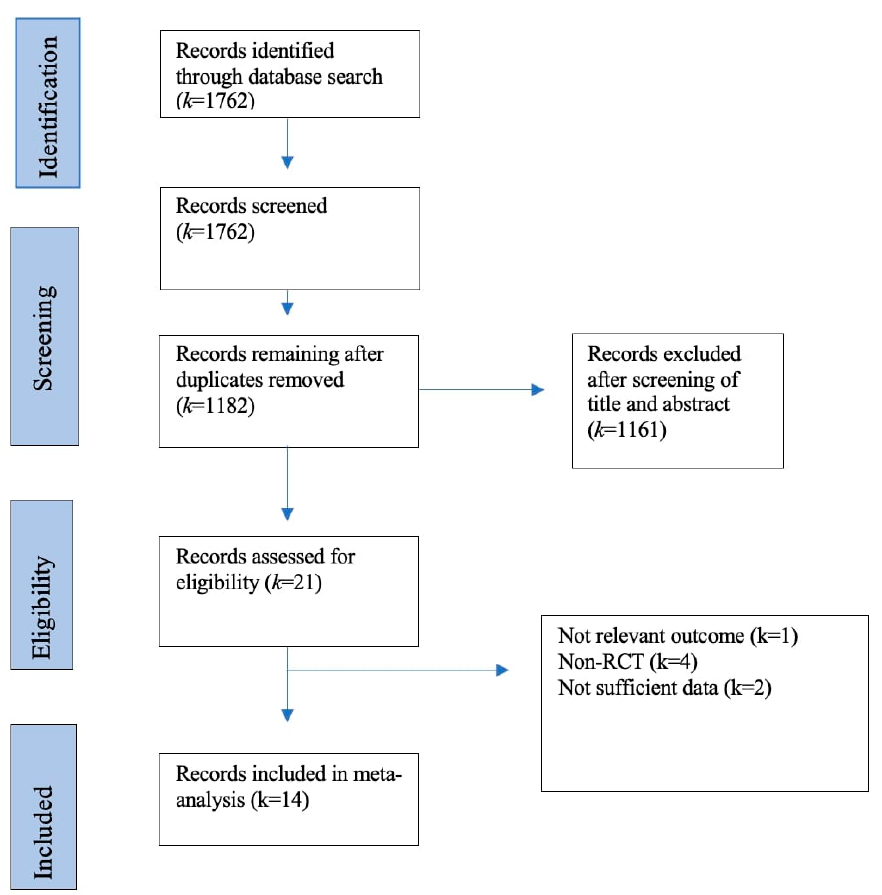
Figure 1. Flow chart of the different phases of the systematic literature search.